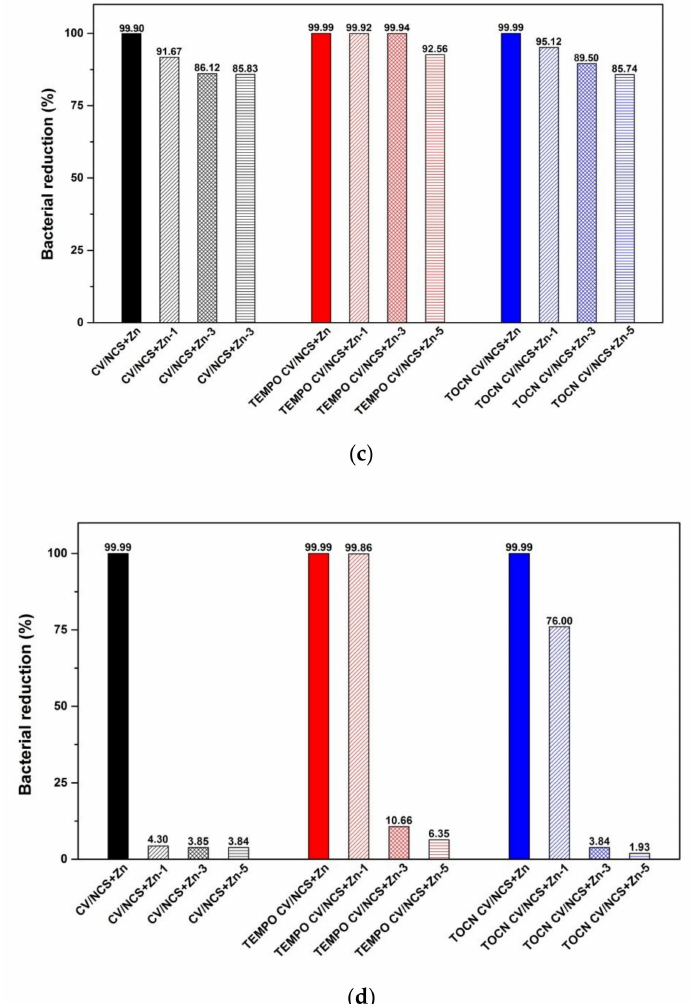
Figure 7. Bacterial reduction of NCS ( a , b ) and NCS + Zn ( c , d ) functionalized viscose fabrics after 1, 3, and 5 washing cycles against S. aureus ( a , c ) and E. coli ( b , d ); modified from